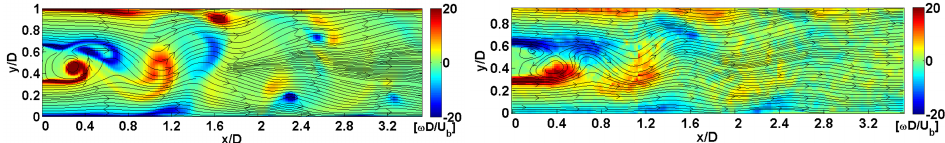
Figure 4. Vortex shedding behind the backplate, spanwise vorticity in the vertical symmetry plane with velocity streamlines (for geometry, see Figure 3a,b). CFD results to the left and PIV results to the right. Figure adapted from